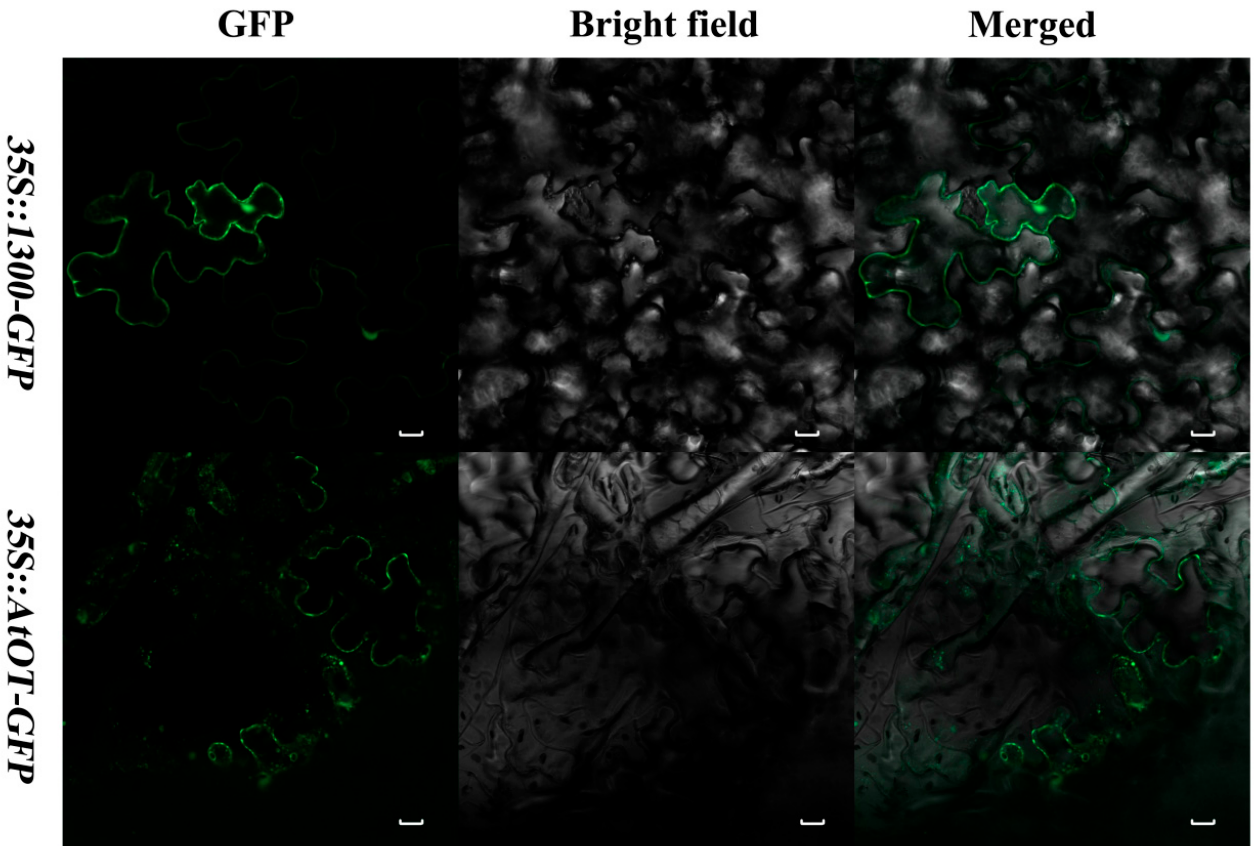
Figure 3. Subcellular localization of AtOT in tobacco leaves. The 35S::AtOT-GFP fusion protein was transiently expressed in tobacco ( N. benthamiana ) leaf epidermal cells. The bars indicate the length of 20 um.